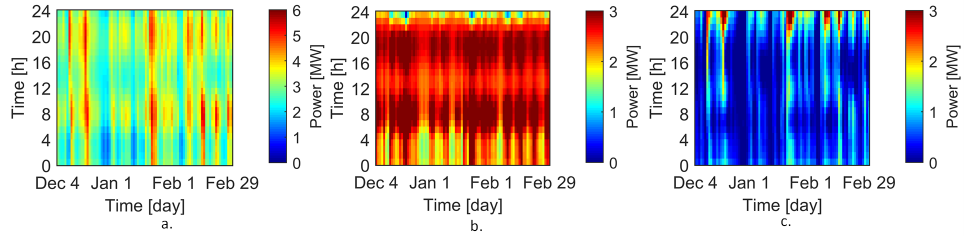
Figure 9. Winter case study for 2019/2020 for forecasted total power ( a ), estimated baseload ( b ), and disaggregated HVAC component separated thorugh the difference between total and baseload ( c